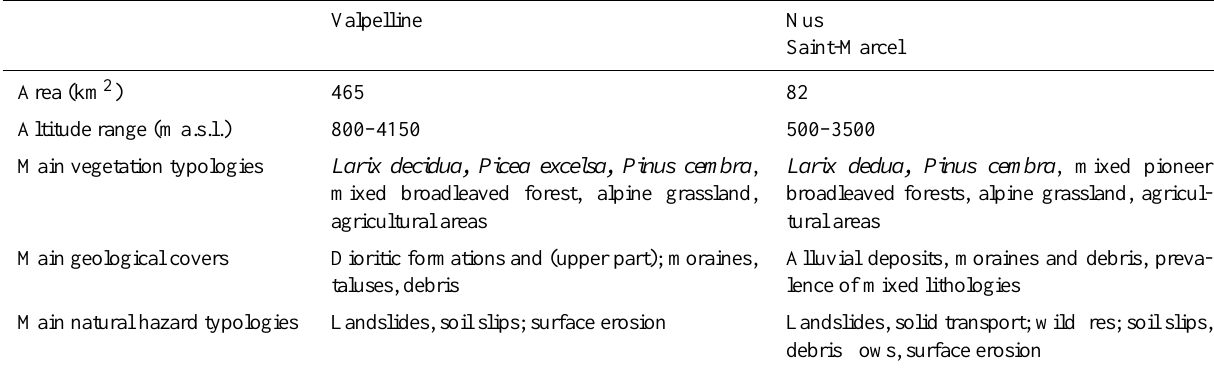
Table 1. Main characteristics of the study areas.